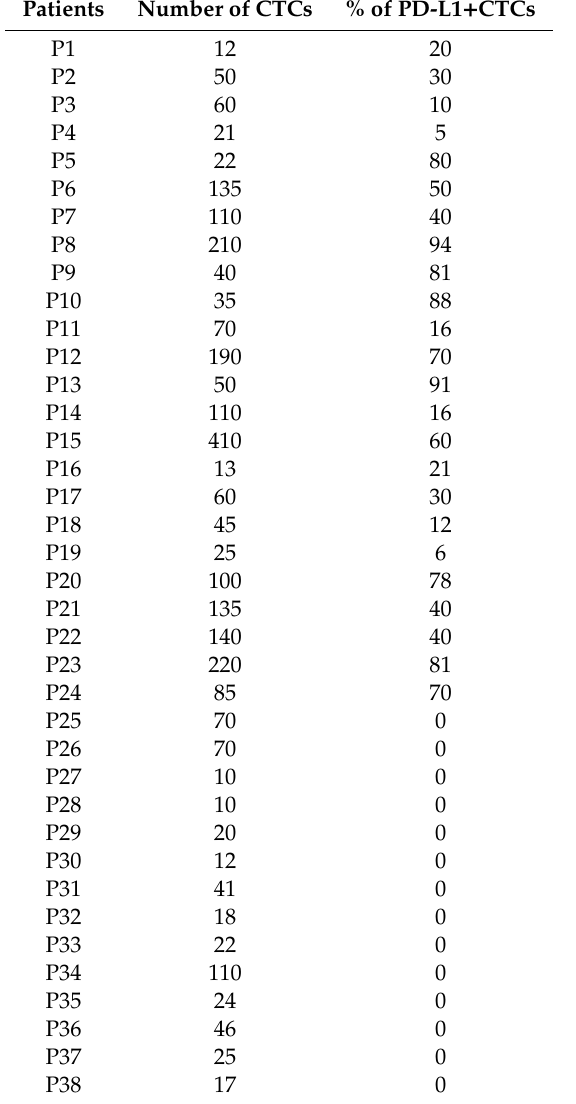
Table A2. Patients’ number of CTCs and percentage of PDL1 +